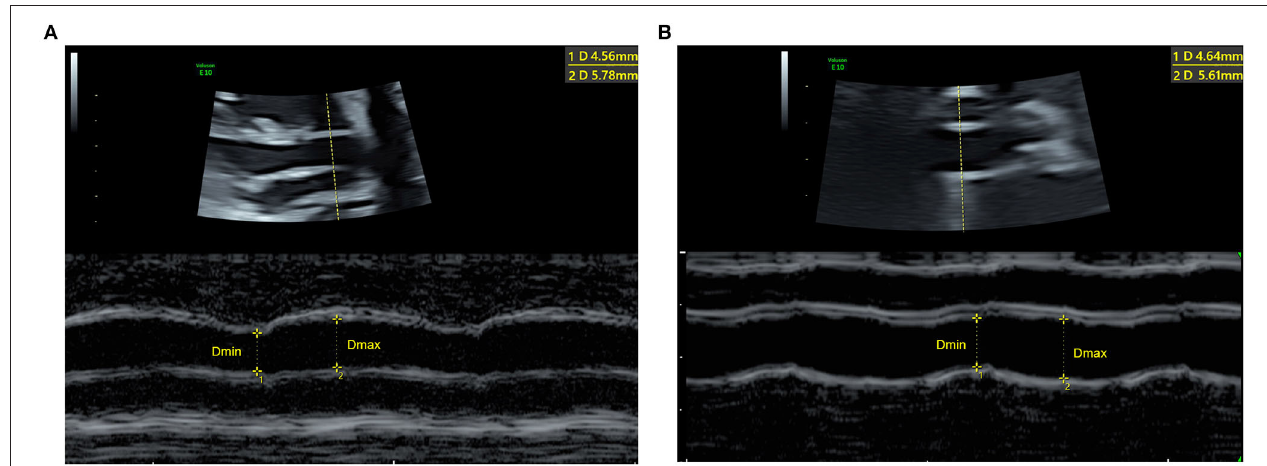
FIGURE 1 | Measurement of the maximum and minimum internal aortic diameters to assess aortic strain from the M-mode echocardiography of a 32-week normal fetus (A) and a 33-week fetus with CoA (B) . Dmin, the minimum internal diameter in the diastolic phase, Dmax, the maximum internal diameter in the systolic